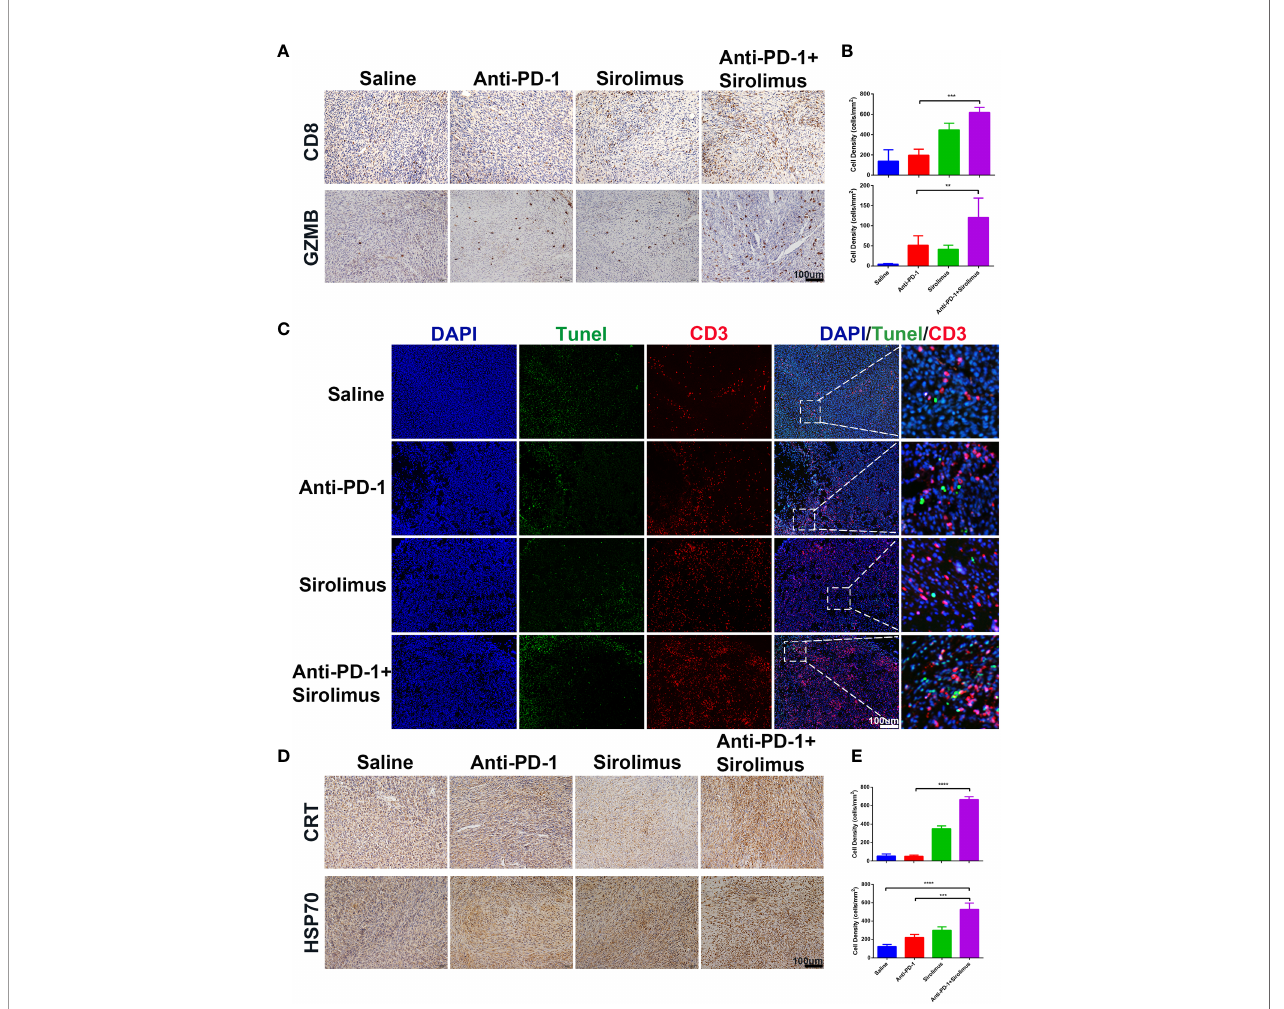
FIGURE 6 | Sirolimus improved the ef fi cacy of anti-PD-1 immunotherapy in vivo . (A) CD8 (upper) and GZMB (bottom) IHC staining of FFPE tumor sections from each group. Scale bar 200 m m. (B) The densities of CD8 + T cells (upper) and GZMB + cells were quanti fi ed. The results were presented as mean ± SD (n=4). ** p < 0.01; *** p < 0.001. (C) CD3 + T cells were co-visualized with TUNEL by immuno fl uorescence staining of FFPE tumor sections from each group. CD3 is shown in red, TUNEL in green. Scale bar 100 m m. (D) CRT (upper) and Hsp70 (bottom) IHC staining of FFPE tumor sections from each group. Scale bar 200 m m. (E) The densities of CRT + (upper) and Hsp70 + (bottom) cells were quanti fi ed. The results were presented as mean ± SD (n=4). *** p < 0.001; **** p <